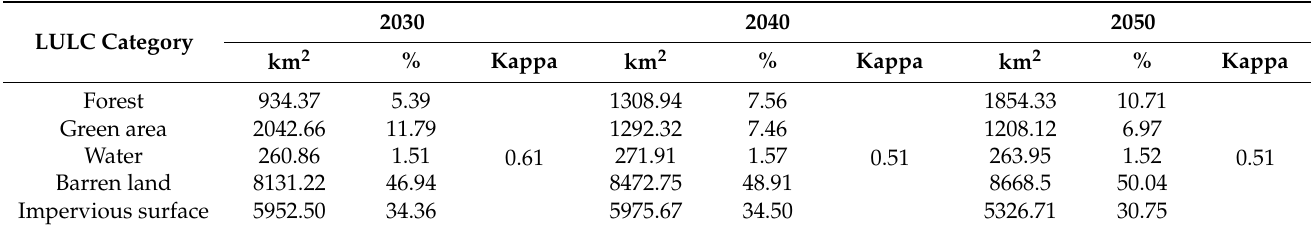
Table 16. Predicted area statistics (2030, 2040, and 2050).